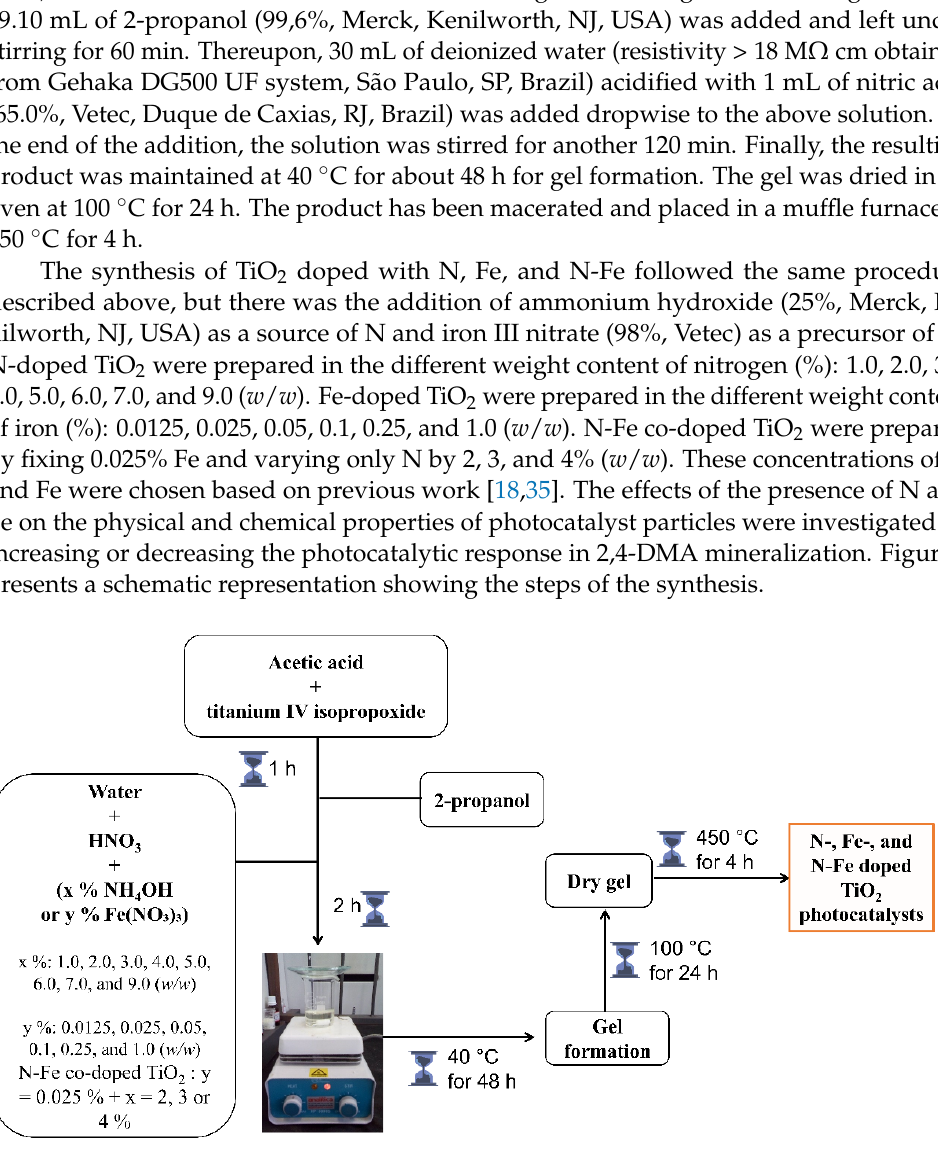
Figure 1. Representative scheme showing the steps of the catalyst synthesis